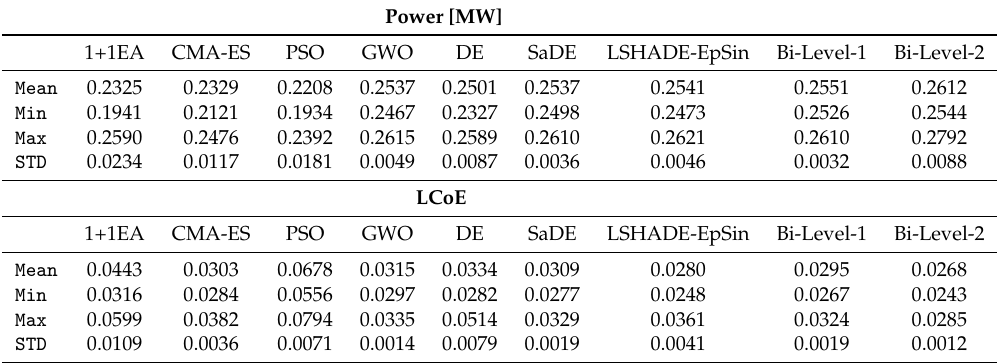
Table 5. Performance comparison of various optimisation methods based on the maximum, minimum and average power output and LCoE of the best-found design per each